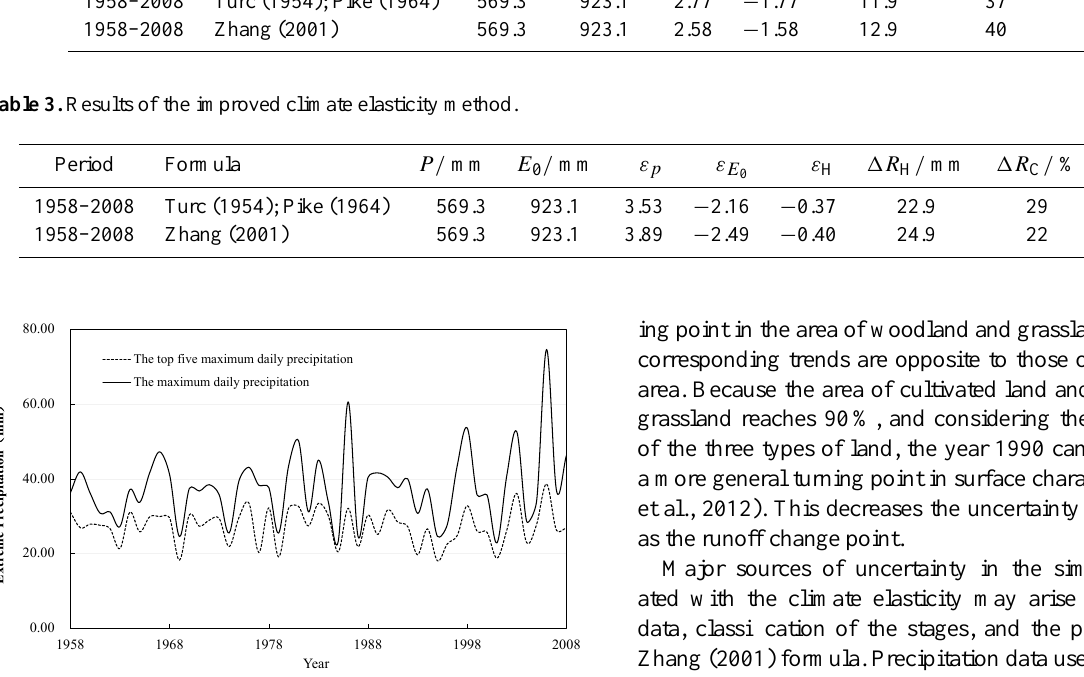
Figure 5. The top five maximum daily precipitation and the maxi- Figure 5 The top five maximum daily precipitation and the maximum daily precipitation curves 601 mum daily precipitation